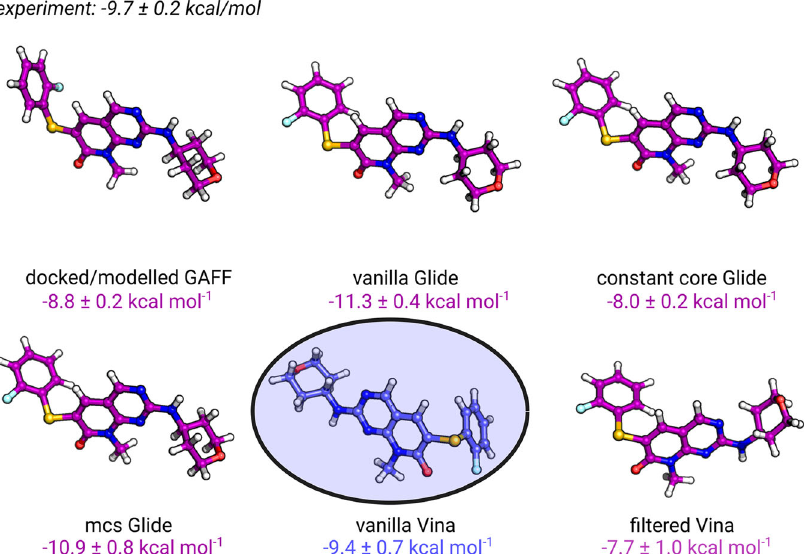
Fig. 7 Impact of core positioning on Δ G prediction for the ligand 2h in the P38 α system. The vanilla Vina pose delivers an accurate free energy prediction compared to the experimental value of − 9.7 ± 0.2 kcal mol − 1 , despite the inverted core (circled) compared to the modelled